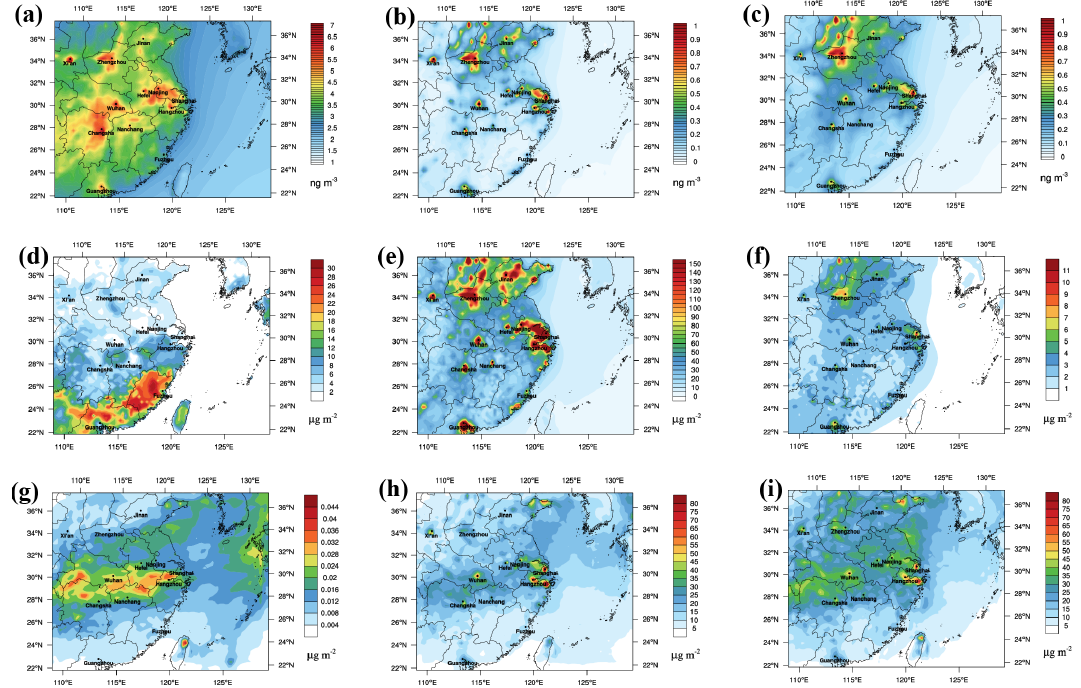
Figure 2. Simulated annual average concentration of (a) GEM, (b) GOM and (c) PBM; annual dry deposition of (d) GEM, (e) GOM and (f) PBM; and dry deposition of (g) GEM, (h) GOM and (i) PBM in eastern China in